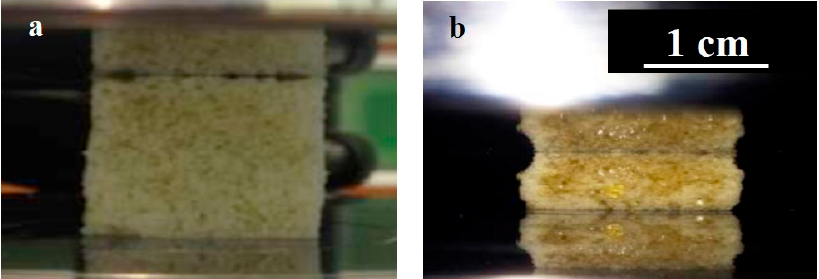
Figure 3. Optical images of BF-PDMS foams between platens: ( a ) before and ( b ) during compression.